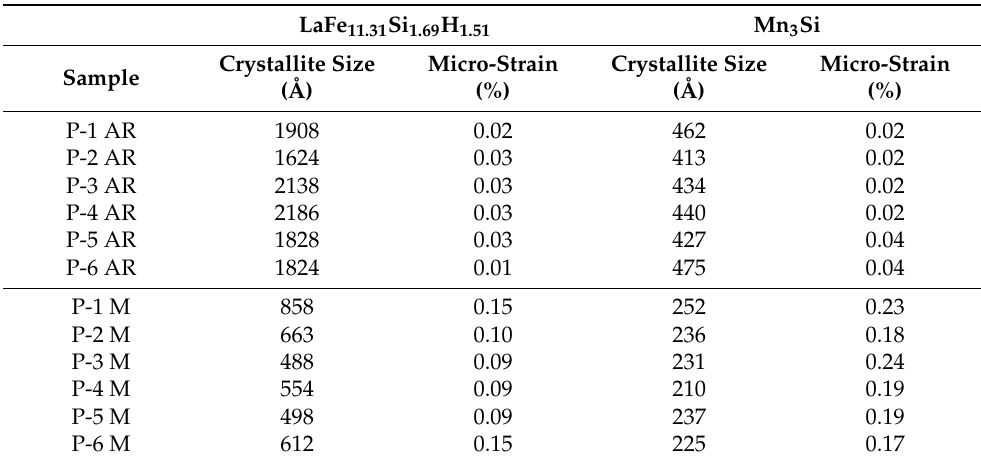
Figure 4. Bar chart comparing the amount of each phase for the ( a ) as-received (ground) (P-1 AR–P-6 AR) and ( b ) milled P-1 M–P-6 M powders, as obtained from the Rietveld refinement analysis. Table 3. The crystallite size and strain for the LaFe 11.31 Si 1.69 H 1.51 and Mn 3 Si phases present in the as-